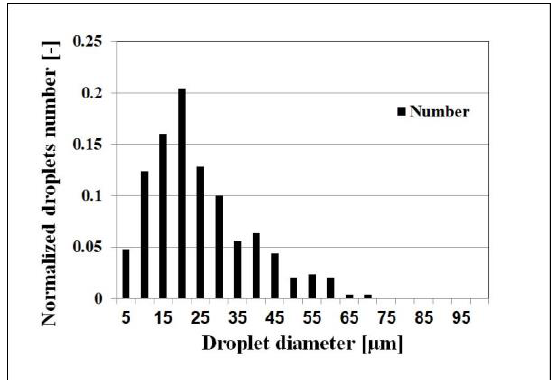
Fig. 3. Normalized number of droplets.